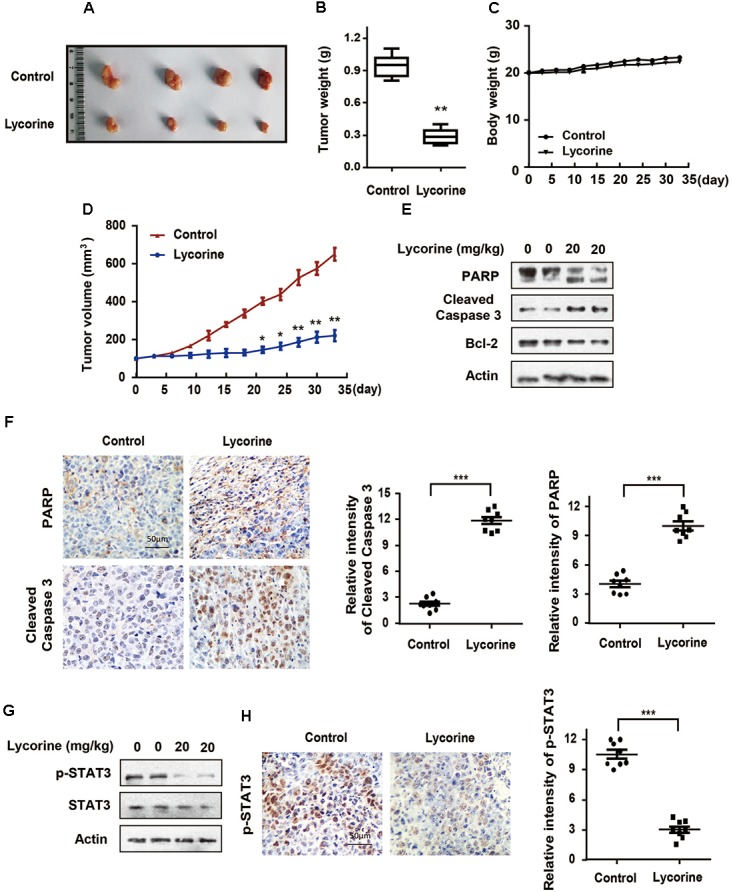
Lycorine blocks growth and development in colorectal SW480 xenograft tumors. (A–H) BALB/c nude mice were inoculated with SW480 cells and treated with lycorine or vehicle. (A) Tumors were isolated and photographed. (B) Tumors were weighted. (C) Bodies were weighted. (D) Tumor volumes were measured every 3 days. (E) PARP, cleaved caspase-3 and Bcl-2 levels were determined in xenograft tumors by Western blot assays. (F) PARP and cleaved caspase-3 expressions were determined by IHC staining in xenograft tumors. (G) p-STAT3 and total STAT3 levels were determined in xenograft tumors by Western blot assays. (H) p-STAT3 expressions were determined by IHC staining in xenograft tumors. For (B,D), data are shown as mean ± SD (n = 9). ∗P < 0.05; ∗∗P < 0.01 compared with control (Student’s t-test). For (F,H), representative images were conducted as indicated. ∗∗∗P < 0.001; Scale bars: 50 μm. All the western data shown are representative of at least three independent experiments.